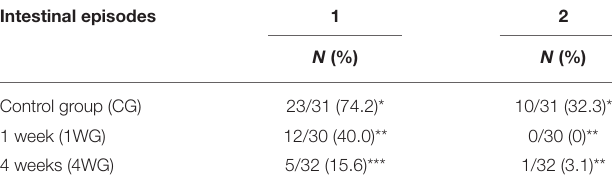
TABLE 2 | Intestinal episodes in the 3 study